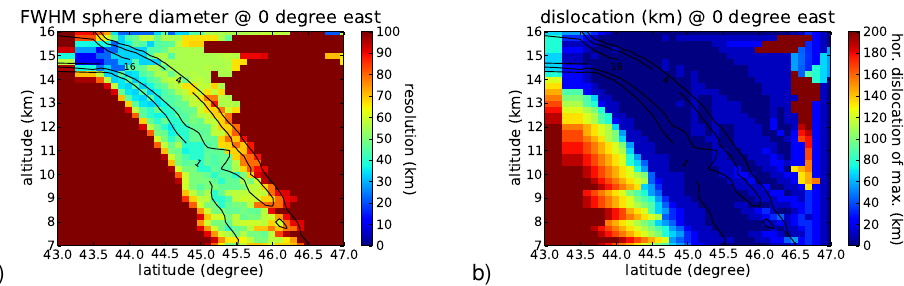
Fig. 6. The resolution and dislocation of the linear flight track. The left panel (a) shows the FWHM sphere diameter. Panel (b) shows the distance between the shown data element and the element with the largest contribution in the associated row of the averaging kernel matrix. The number of tangent points within the depicted volume elements is overlaid as a contour plot.